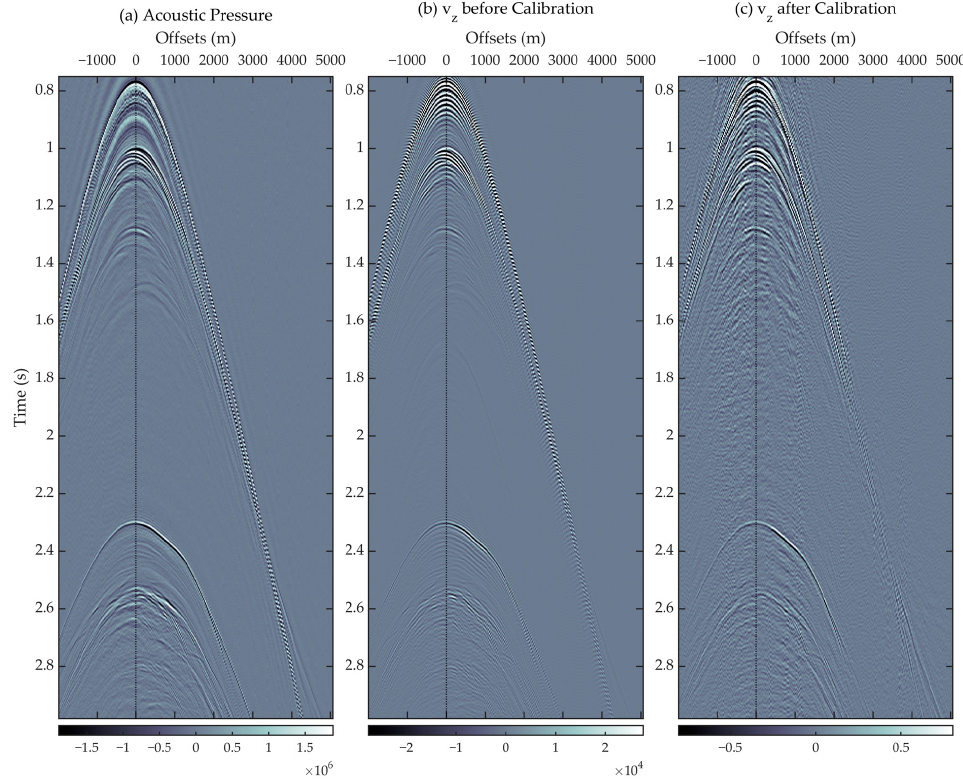
Figure 7. Comparison of the ( a ) acoustic pressure component, and vertical particle velocity component ( b ) before and ( c ) after calibration, in the t - x domain. Because of the relatively wide display range, we use a blue–grey colormap to avoid visual interferences brought by high-contrast colors.